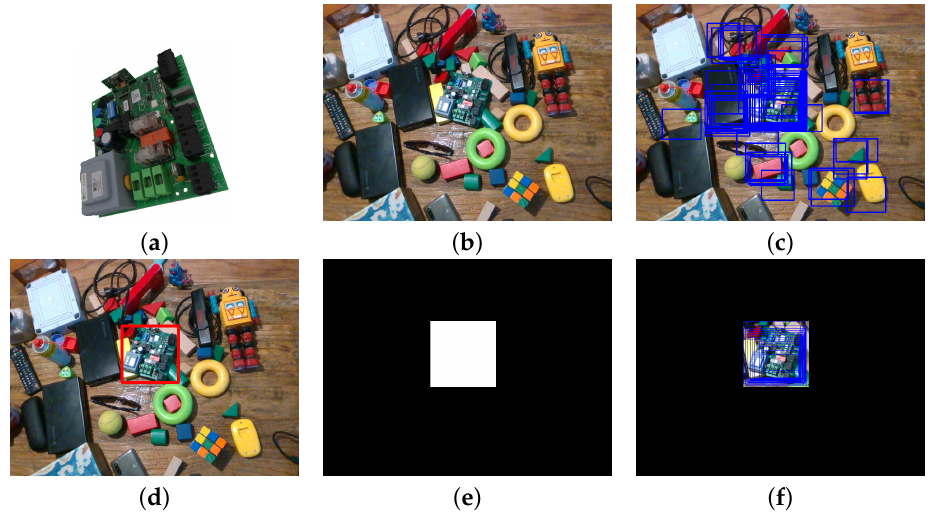
Figure 4. LINEYOLO method—LINEMOD with YOLOV4: ( a ) 3D model; ( b ) Raw cluttered scenario image; ( c ) Detection results using the LINEMOD method; ( d ) Detection results using YOLOV4; ( e ) Extracted mask from the result of the YOLOV4 algorithm; and ( f ) LINEMOD detection method results after using YOLOV4 algorithm ROI